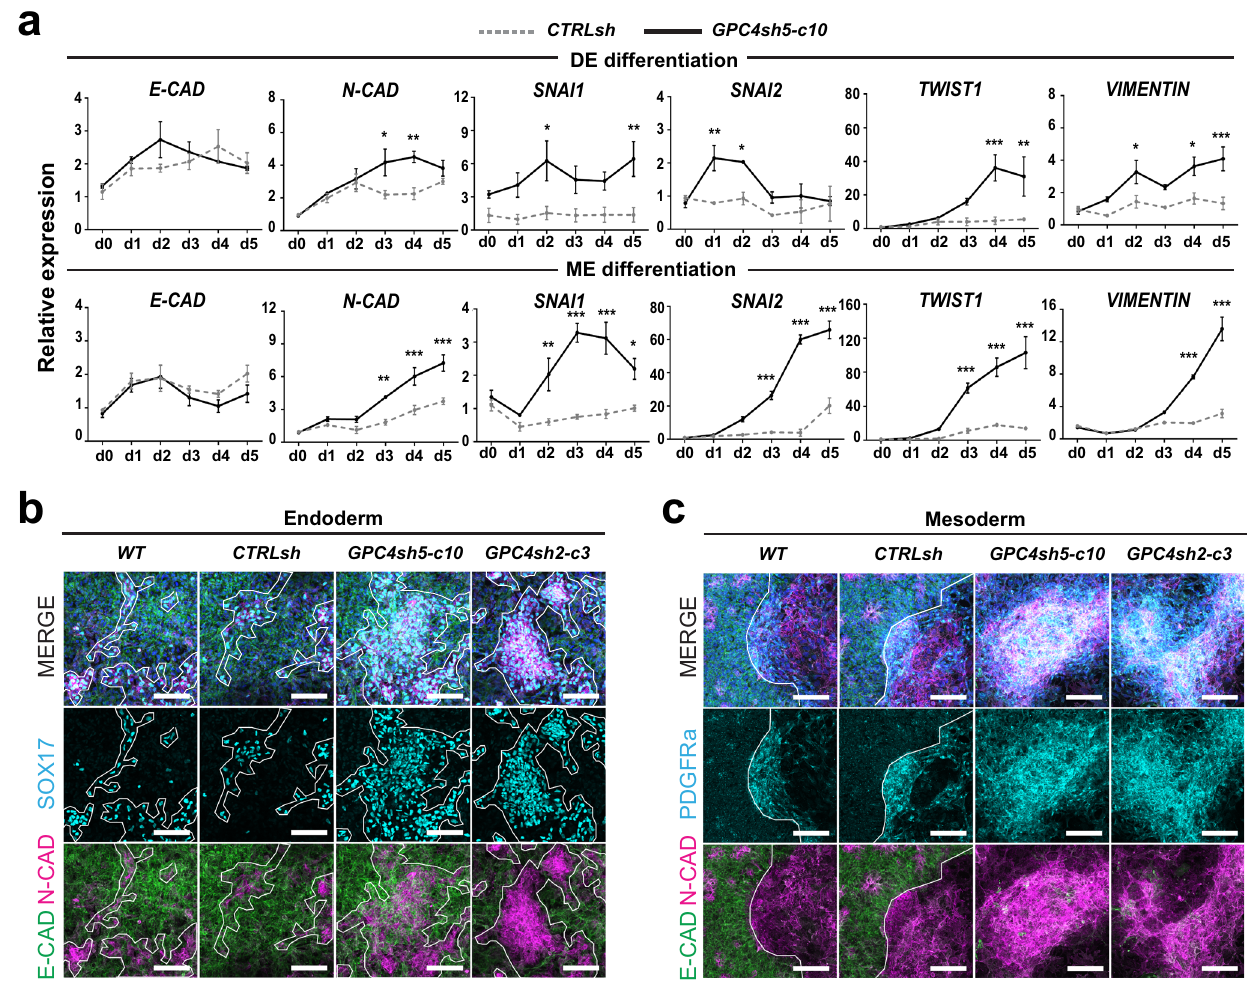
Fig. 3 | Analysis of EMT in GPC4shcells. a RT-qPCR analysisoftranscript levelsof E-CAD, N-CAD, SNA1, SNAI2, TWIST1 and VIMENTIN in CTRLsh and GPC4sh5-c10 029 hiPSCs differentiated for 5days into DE or ME. Top panel: DE differentiation andbottompanel:MEdifferentiation.DatawerenormalizedtothemeanofCTRLsh Δ Ct atd0and represented asmean±SEM, n =3. b , c Immuno fl uorescenceanalysis of N-CAD(magenta), E-CAD(green),SOX17(cyan, DE) or PDGFRa (cyanME)inWT,